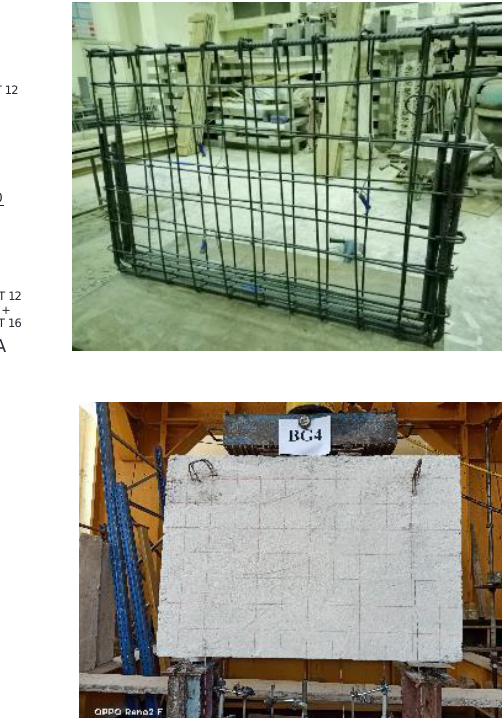
Table 1: Specimen’s reinforcement details.